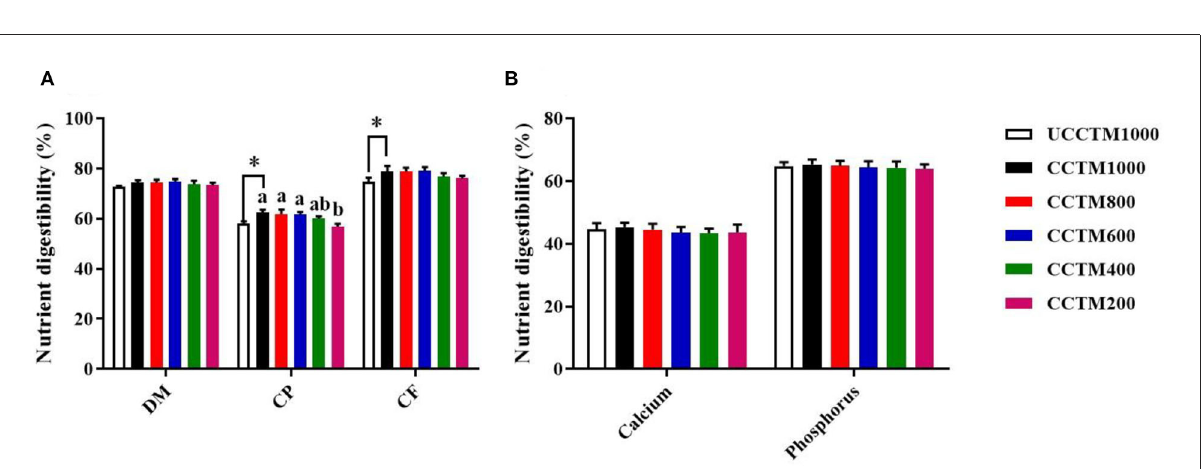
FIGURE2 Effects of dietary coated complex TMs on nutrient digestibility of yellow-feathered broilers. The digestibility of (A) dry matter (DM), crude protein (CP), crude fat (CF), and (B) Calcium, and phosphorus were examined. Results are mean value ± standard error (SE); n = 6 for each group. * P < 0.05 for the UCCTM1000 group vs. the CCTM1000 group. Mean values with different small letters denote significant differences among CCTM groups ( P < 0.05). UCCTM1000, supplemented with 1,000 mg/kg of uncoated complex trace minerals; CCTE1000, supplemented with 1,000 mg/kg of coated complex trace minerals; CCTE800, supplemented with 800 mg/kg of coated complex trace minerals; CCTE600, supplemented with 600 mg/kg of coated complex trace minerals; CCTE400, supplemented with 400 mg/kg of coated complex trace minerals; CCTE200, supplemented with 200 mg/kg of coated complex trace